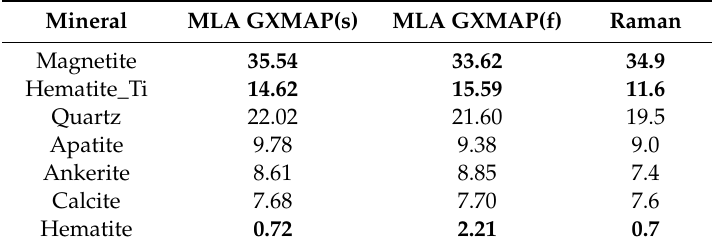
Table 2. Modal mineralogy (area %) of major and minor components obtained by SEM + MLA and Raman measurements on sample HA-81155-2. Fe-oxides are highlighted for better comparison. Mineral MLA GXMAP(s) MLA